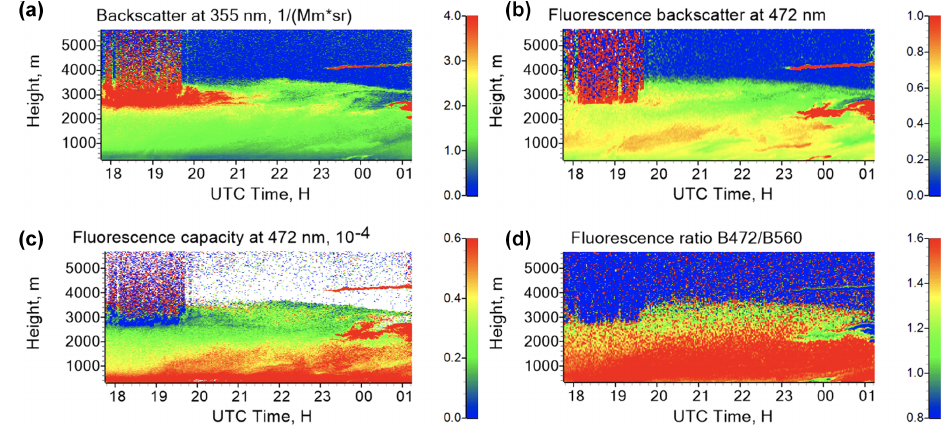
Figure 10. Spatiotemporal distributions of the particle parameters on the night of 23–24 August 2022. (a, c) The aerosol-backscattering coefficient β 355 together with the fluorescence capacity G 472 . (b, d) The fluorescence-backscattering coefficient β F472 (in 10 − 4 Mm − 1 sr − 1 ) and the ratio B 472 /B 560